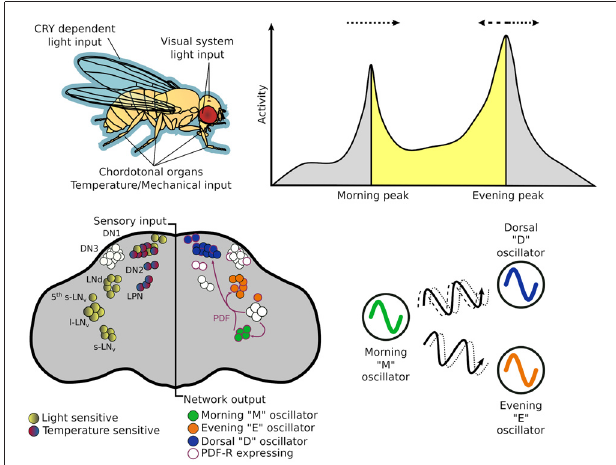
FIGURE 2 | The circadian system of Drosophila melanogaster from input stimulus to output behavior. Light information may enter the circadian system through the cuticle of the fly to directly act on CRY, which is expressed in many central and peripheral clock cells. Alternatively, it may enter via sensory cells of the visual systems—compound eye, H-B eyelets or the ocelli that make direct—or indirect — synaptic contact with central clock neurons. While flies have many thermo - and mechano-sensing organs, chordotonal organs (ChOs) have been directly implicated in communicating both temperature and mechanical stimuli to the circadian system. The neuronal populations of central pacemakers differ in their sensitivity to external stimuli as well as their neurochemical and electrical connectivity. Pacemaker neurons expressing CRY preferentially entrain to light cues while others not expressing CRY have demonstrated preference for temperature cues. Neurochemical differences can denote distinct functional groups—for example the M oscillator neurons express and release pigment dispersing factor (PDF) that can lead to phase changes in molecular oscillations of cells expressing PDF-R. This can result in phase advances or delays of downstream processes that in turn can advance or delay behavioral